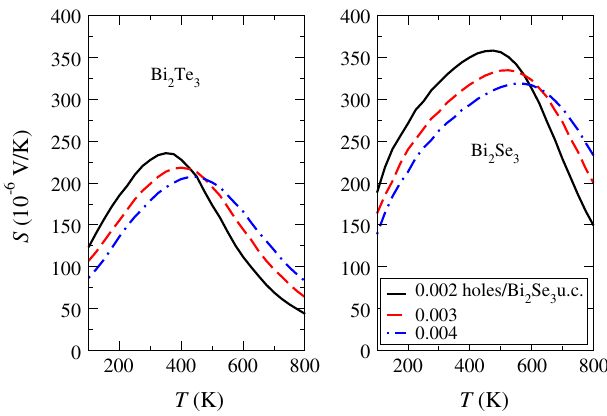
FIG. 5. The calculated thermopower for Bi 2 Se 3 and Bi 2 Te 3 at the indicated carrier concentrations. Lines of the same color and character have equal carrier concentrations.